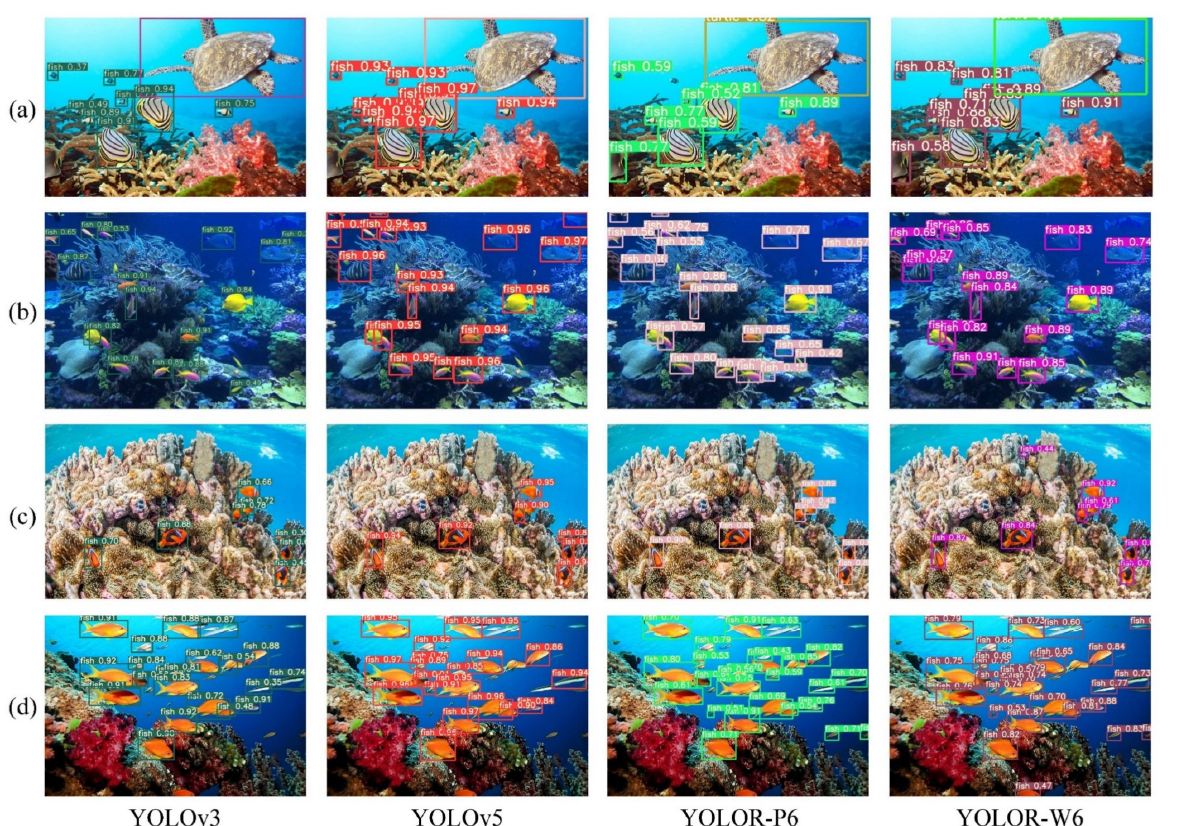
Figure 5 . Examples of marine animal detection.